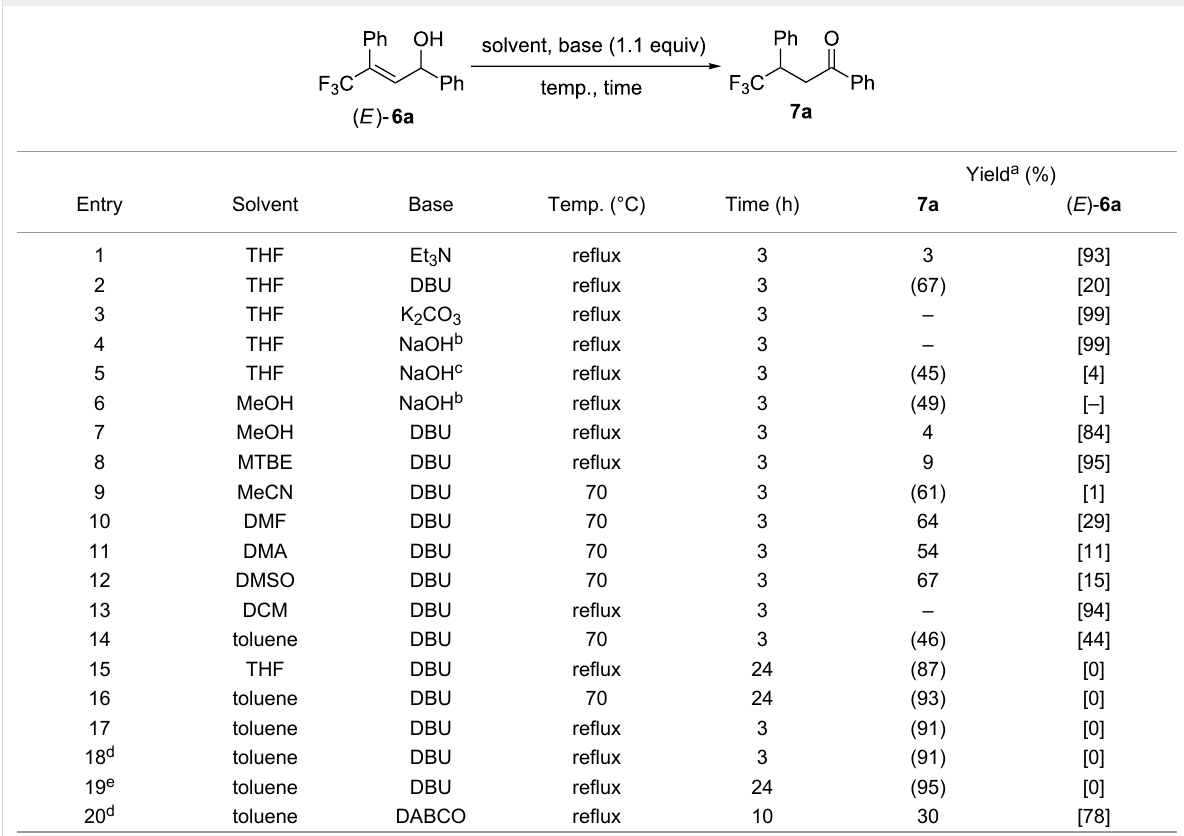
Table 2: Optimization of reaction